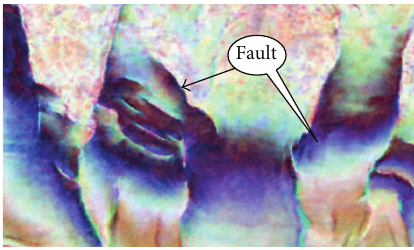
Figure 8: Slice of the color-blended volume.